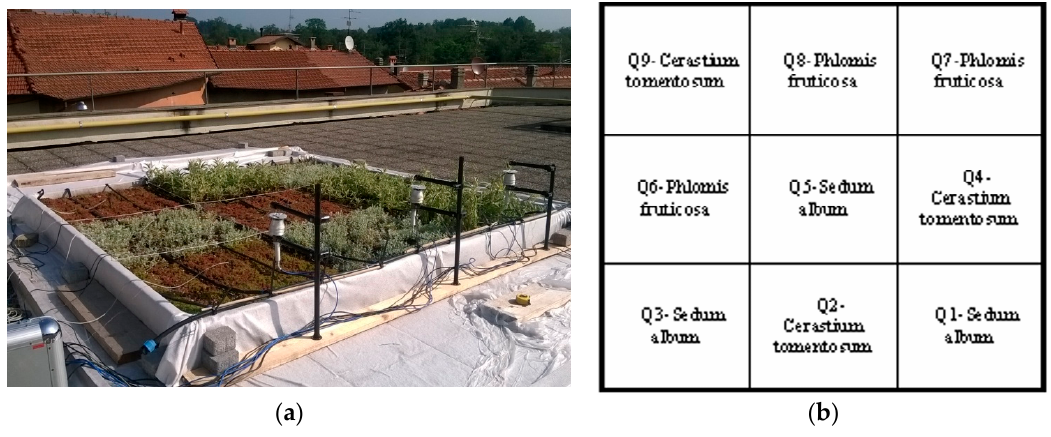
Figure 2. Imagine of: ( a ) the measurement area; and ( b ) scheme of the plant species planting. The random position of the three plots for each plant species was deliberately chosen to ensure, through average data, the reduction and limitation of behavior discrepancies due to the boundaries of the test area.